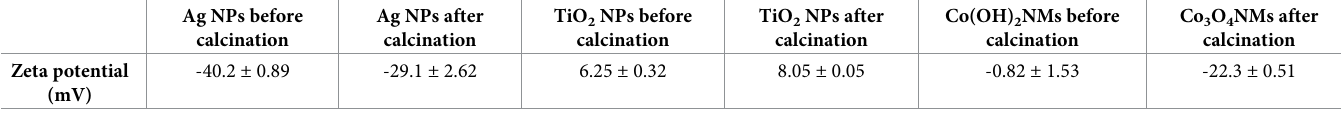
Table 3. Average zeta potential measurements and their standard